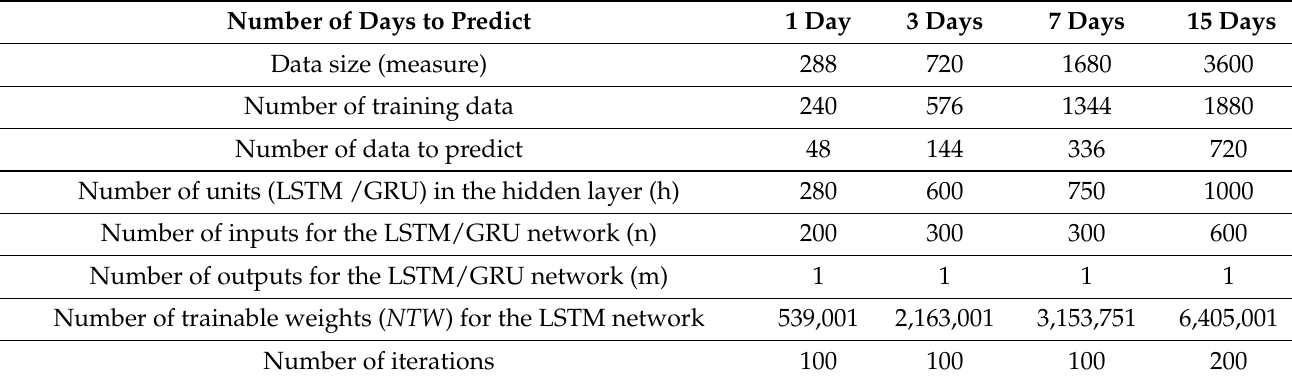
Table 2. LSTM forecasting